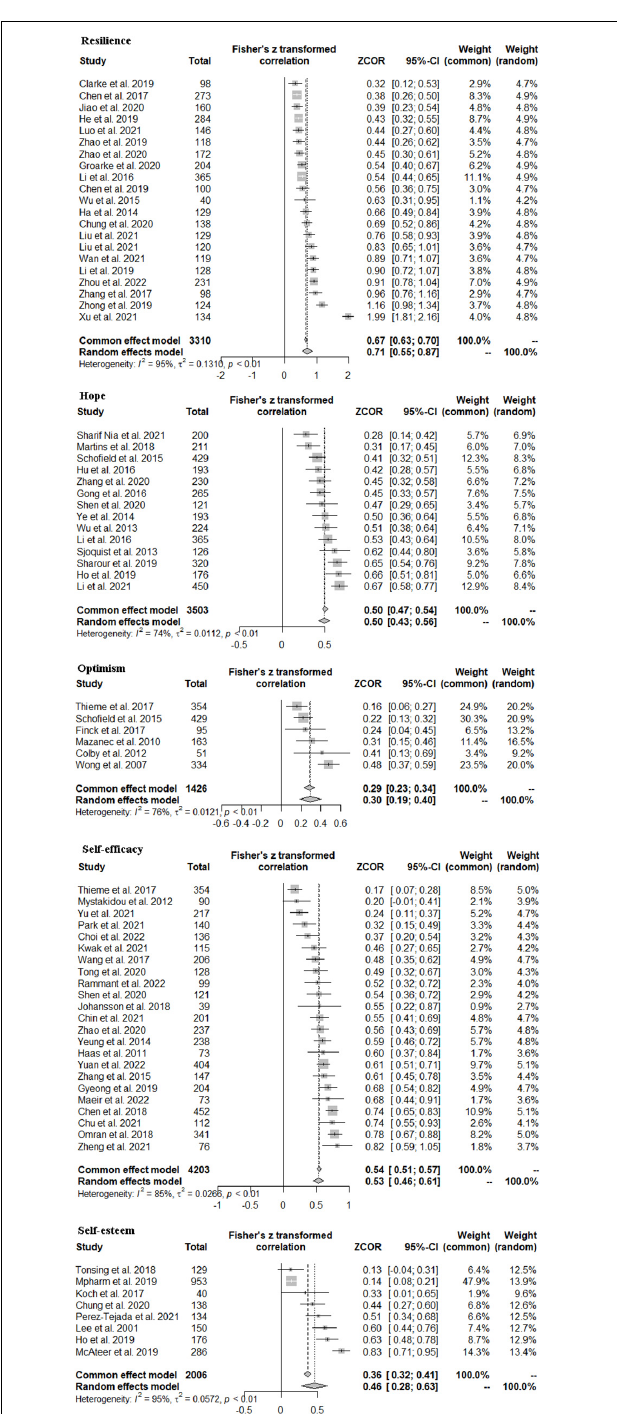
FIGURE 2 | Effect sizes of the correlation between five positive psychological resources and quality of life.